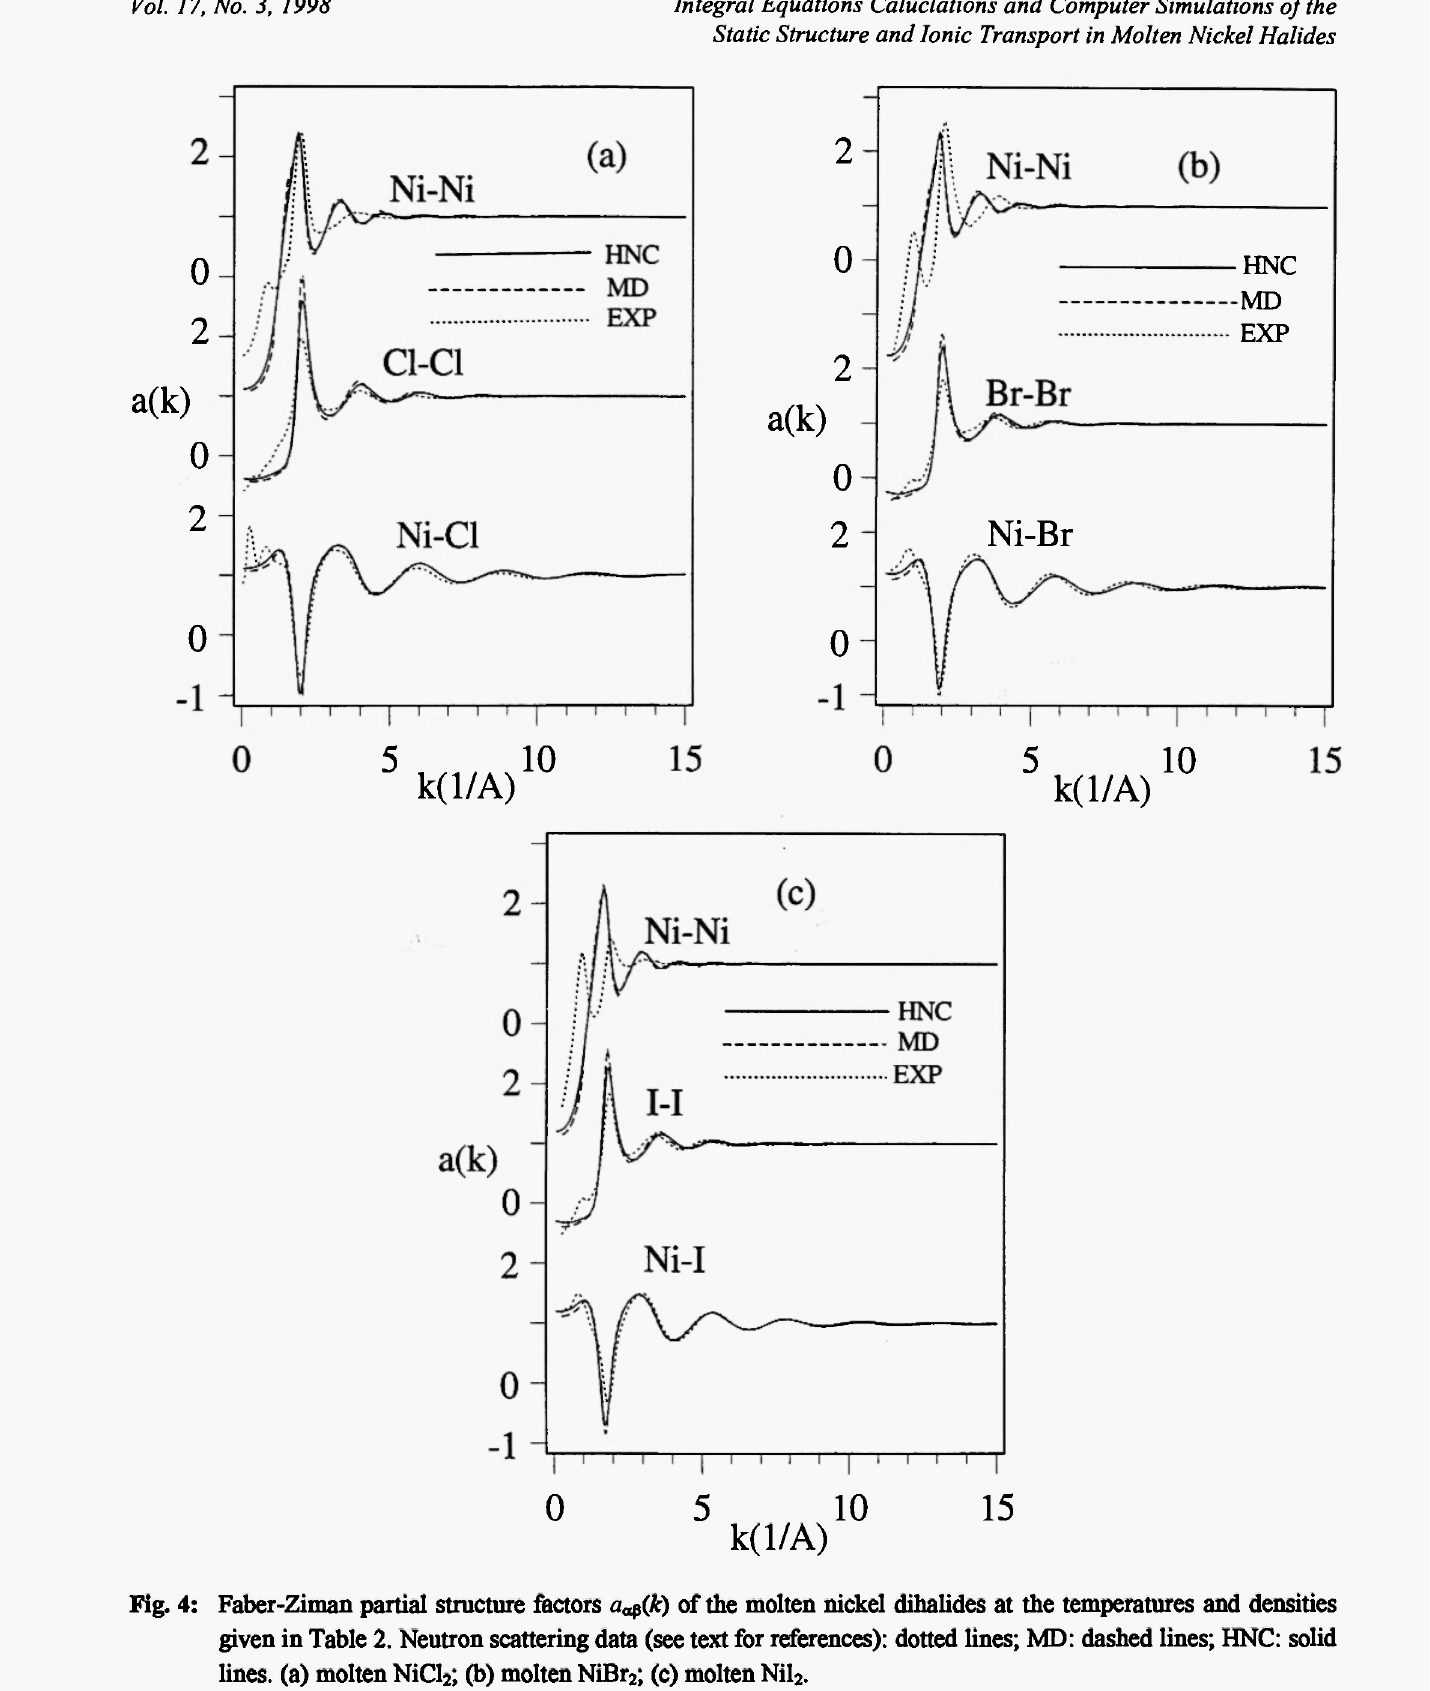
Fig. 4: Faber-Ziman partial structure factors a^Qc) of the molten nickel dihalides at the temperatures and densities given in Table 2. Neutron scattering data (see text for references): dotted lines; MD: dashed lines; HNC: solid lines, (a) molten NiCl ; (b) molten NiBr ; (c) molten Nil . 2 2 2